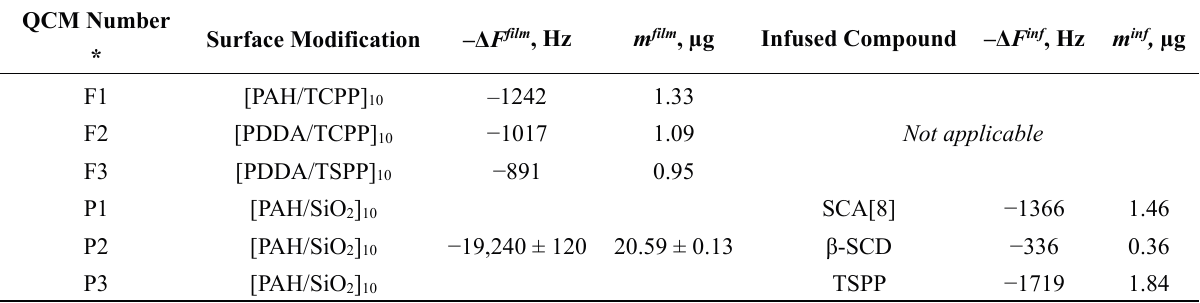
Table 1. Electrodes used in the experimental